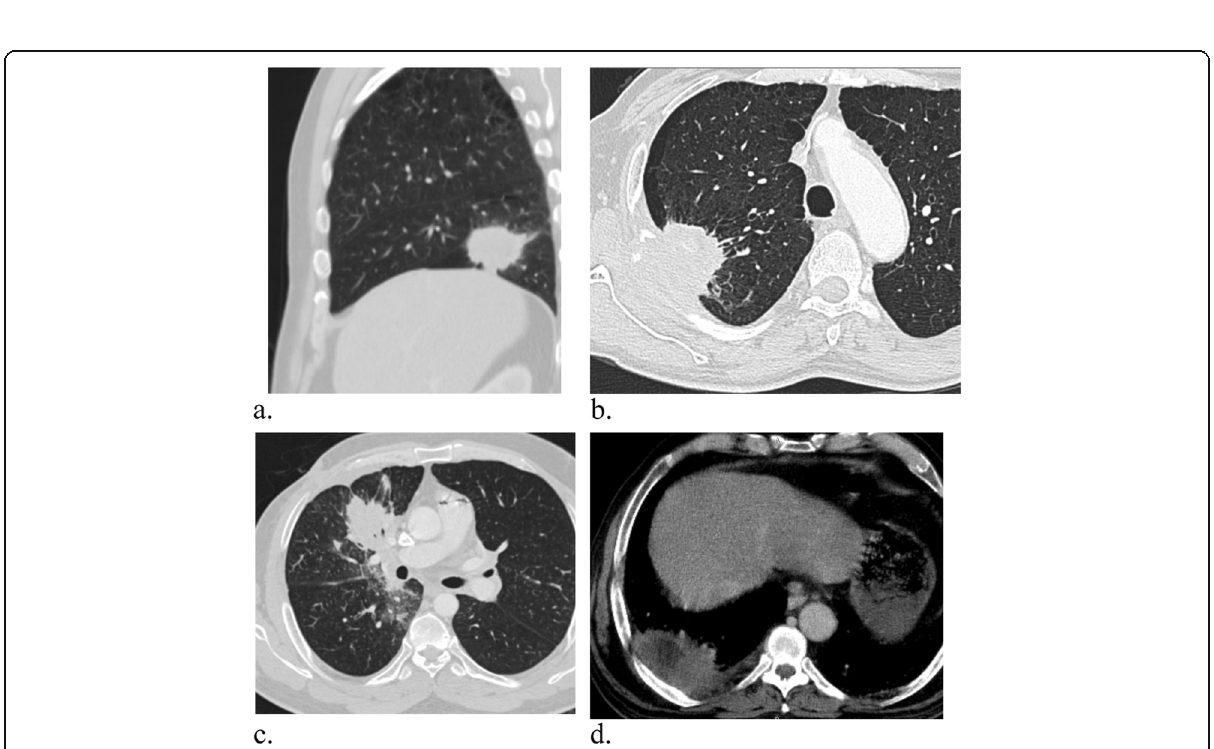
Fig. 2 Four different cases of right-sided adenocarcinoma. a , b , and c show the classical solid speculated mass lesion with pleural and chest wall invasion in image b , bronchial invasion in image c . In image d , the lesion is thick-walled cavitary lesion with pleural